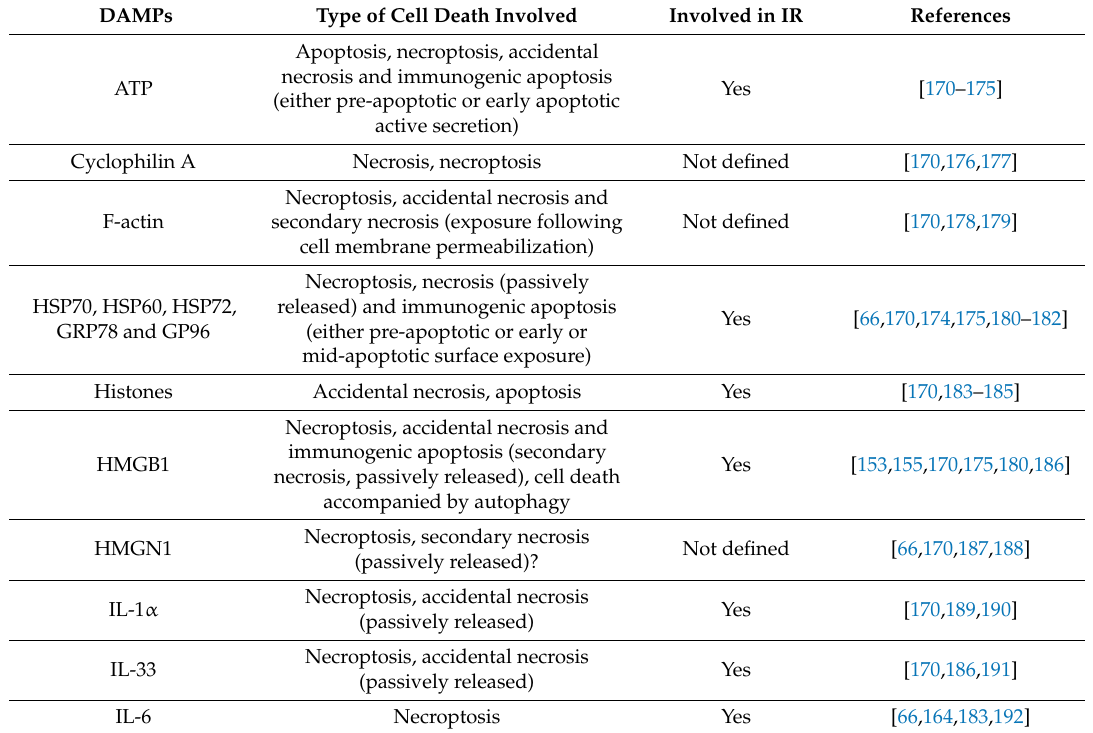
Table 1. Overview of DAMPS associated with di ff erent types of cell death. The table is modified from Reference